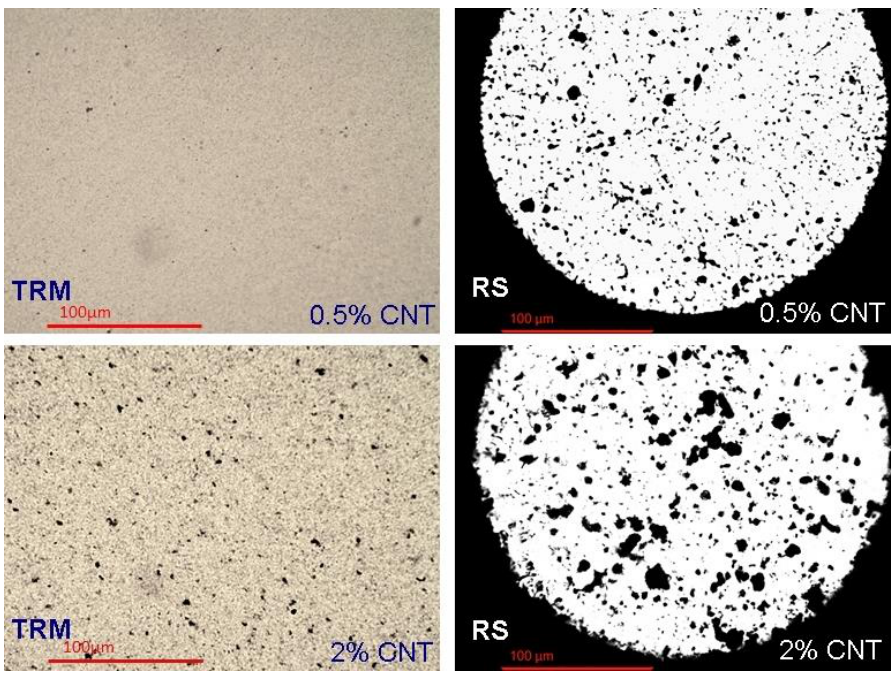
Figure 11. Variation of dispersion method and MWCNTs content: Left side: TRM method, right : RS method, above: 0.5 wt.% MWCNTs, below: 2 wt.% MWCNTs.